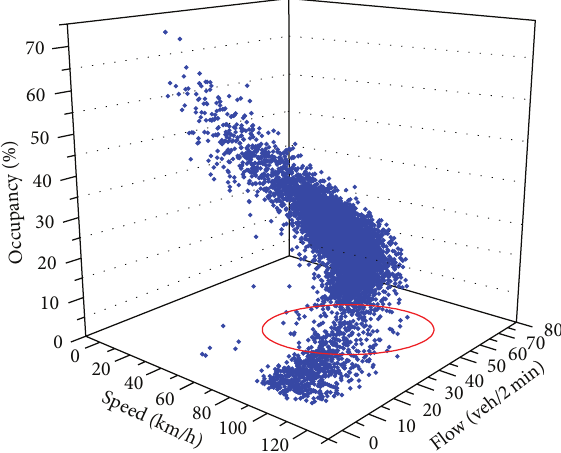
Figure 2: Scatter illustration of flow-speed-occupancy from RTMS 3060. Small blue points stand for the traffic characteristics in flow-speed-occupancy space, and the red ellipse separates the free condition with congested condition. Symbols show conditions of